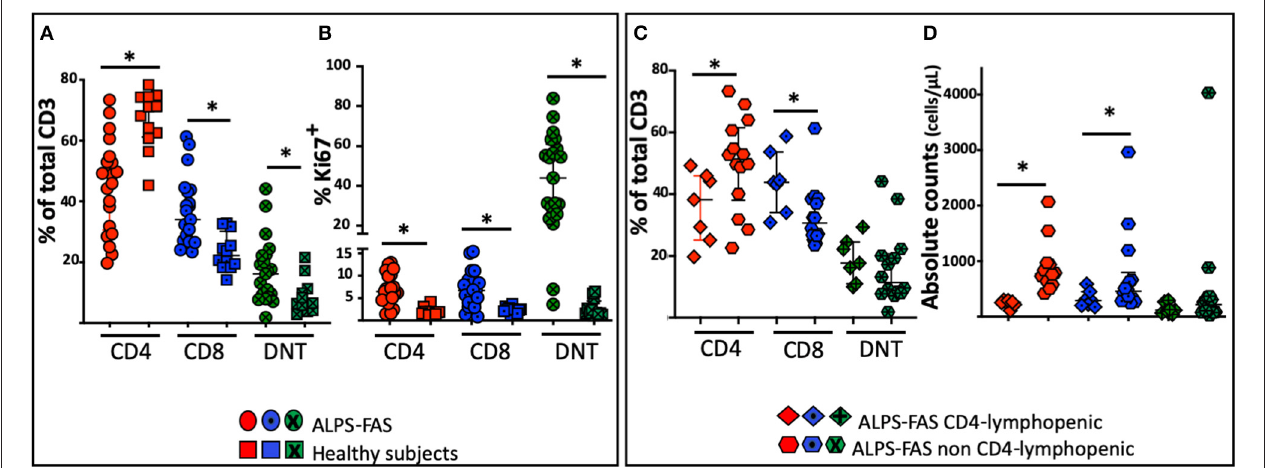
FIGURE 3 | Distribution of the proportion of CD4, CD8, and DNT-cells in patient with ALPS-FAS and CD4 lymphopenia, matched controls subjects with ALPS-FAS and healthy subjects. *Comparisons with statistically significant differences. (A) Proportion of CD4, CD8, and DNT cells in patients with ALPS-FAS (circles) and healthy subjects (squares). (B) Proportion of Ki67 expressing CD4, CD8, and DNT cells in patients with ALPS-FAS (circles) and healthy subjects (squares). (C) Proportion of CD4, CD8, and DNT-cells in ALPS-FAS patients with (diamonds) or without (hexagons) CD4 lymphopenia. (D) Absolute counts of CD4, CD8, and DNT-cells in ALPS-FAS patients with (diamonds) or without (hexagons) CD4